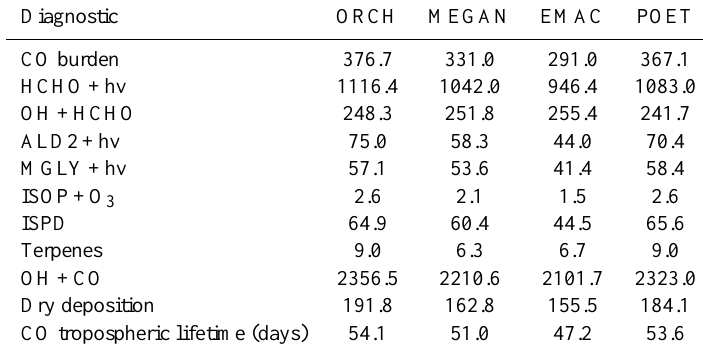
Table 4. The annually integrated chemical budget terms for the in-situ production of tropospheric CO during 2000 for the four individual members of the model ensemble. The height of the troposphere is defined using the method defined in Stevenson et al. (2006). All burdens are given in TgCOyr − 1 .